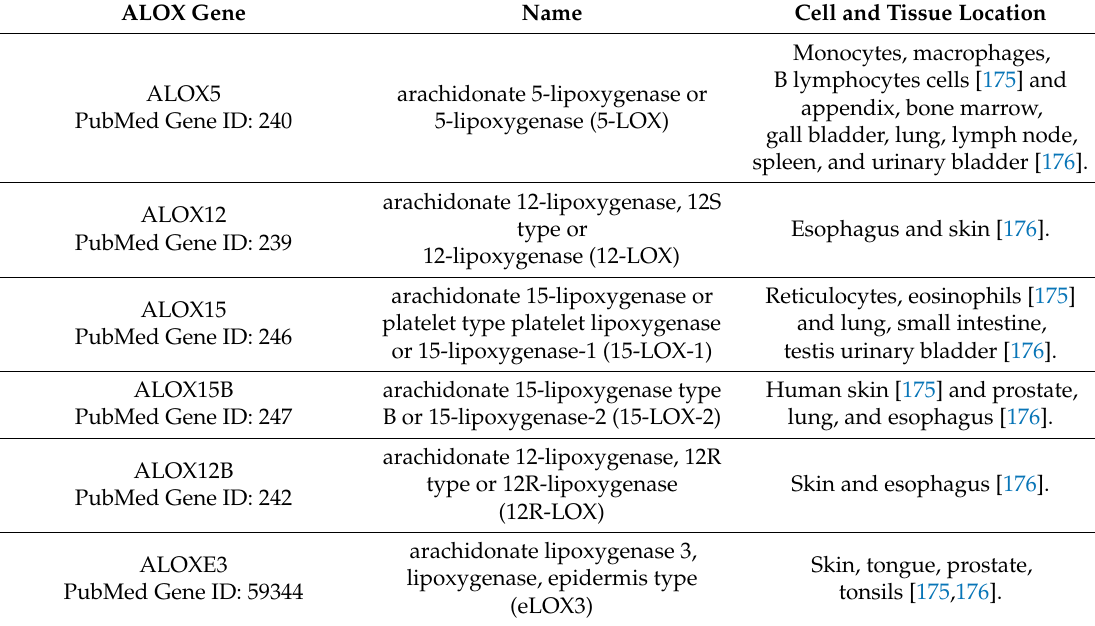
Table 2. Human lipoxygenases (LOXs) genes classification and expression in cells and